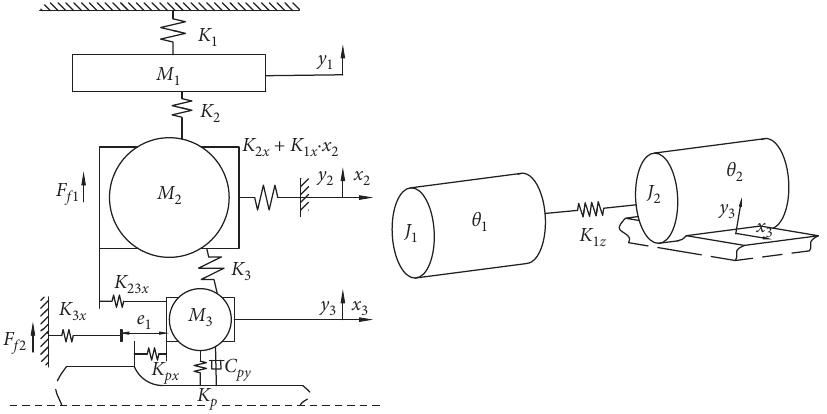
Figure 4: Geometry of the vertical-horizontal-torsional vibration